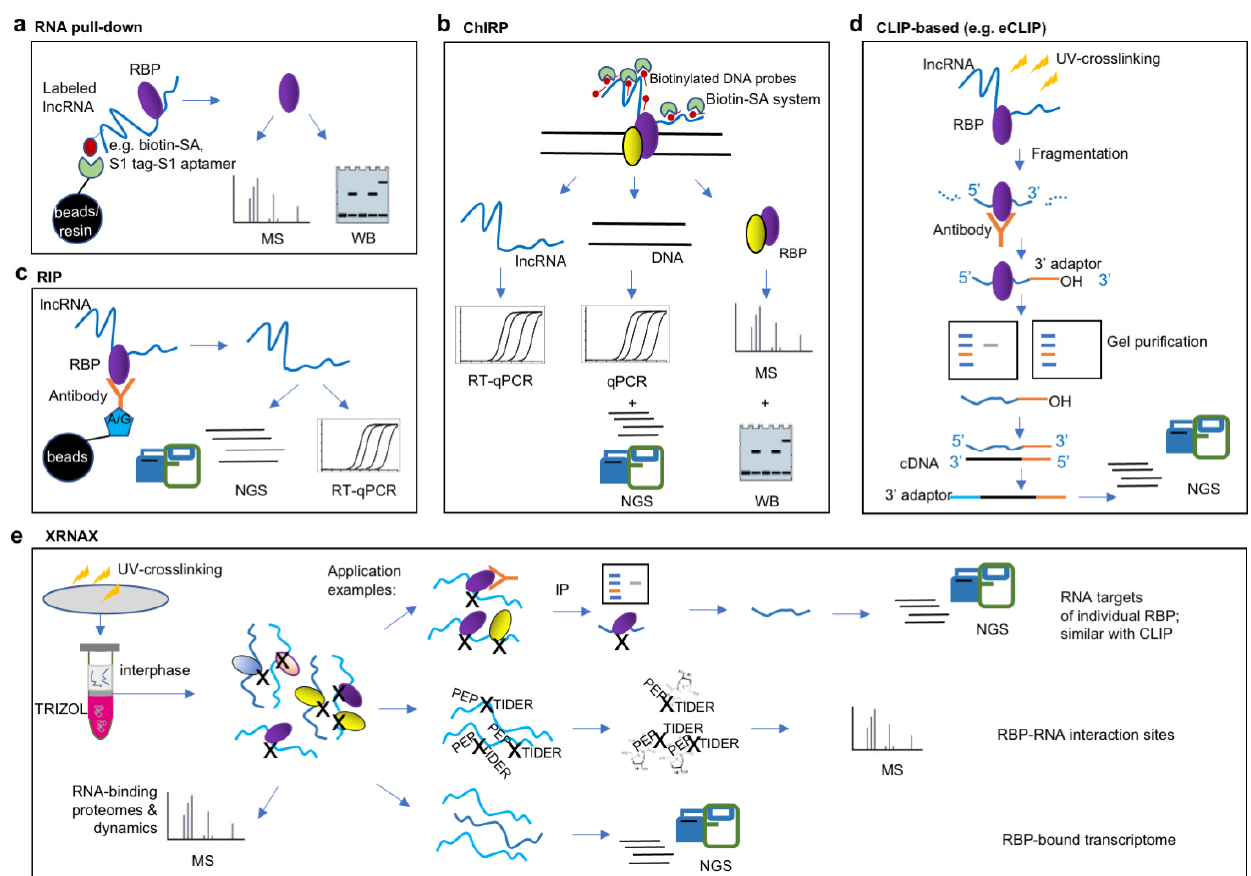
Figure 1. Methodologies for detecting lncRNA–protein interactions. ( a ) RNA pull-down is an “in vitro” procedure that use biotin or aptamer tag-labeled lncRNA as a ‘bait’ to bind interacting proteins, followed with identification of proteins by Western blot (WB) or protein quantitative mass spectrometry (MS) to characterize proteins bound to the lncRNA of interest. ( b ) Chromatin isolation by RNA purification (ChIRP) is based on affinity capture of target lncRNA:chromatin complex using biotinylated antisense probes of lncRNA, the resulting DNA and RBPs were determined by next-generation sequencing (NGS) and protein quantitative MS, respectively. ( c , d ) Both RNA immunoprecipitation (RIP) and crosslinking-immunprecipitation (CLIP)-based approaches use antibodies against the RBP of interest to pull-down its interacting RNAs. RIP was combined with RT-qPCR for confirmation of interaction with a candidate lncRNA, or subjected to NGS for ‘one-to-all’ screening of interacting lncRNAs ( c ). Specifically, CLIP-based approach, such as enhanced CLIP (eCLIP) uses UV cross-linking, fragmentation, immunprecipitation and gel purification to preserve the direct binding sites of target lncRNAs ( d ). ( e ) Protein-crosslinked RNA extraction (XRNAX) is a resourceful approach that purifies protein-crosslinked RNA of all biotypes from UV-crosslinked cells. XRNAX uses conventional TRIZOL extraction and collects the TRIZOL interphase for fur- ther purification, the resulting crosslinked protein-RNA complexes allows multiple applications including CLIP-seq, protein quantitative MS and NGS analysis for determination of RNA targets of individual RBP, RNA-binding proteomes and dynamics, RBP–RNA interaction sites and RBP-bound